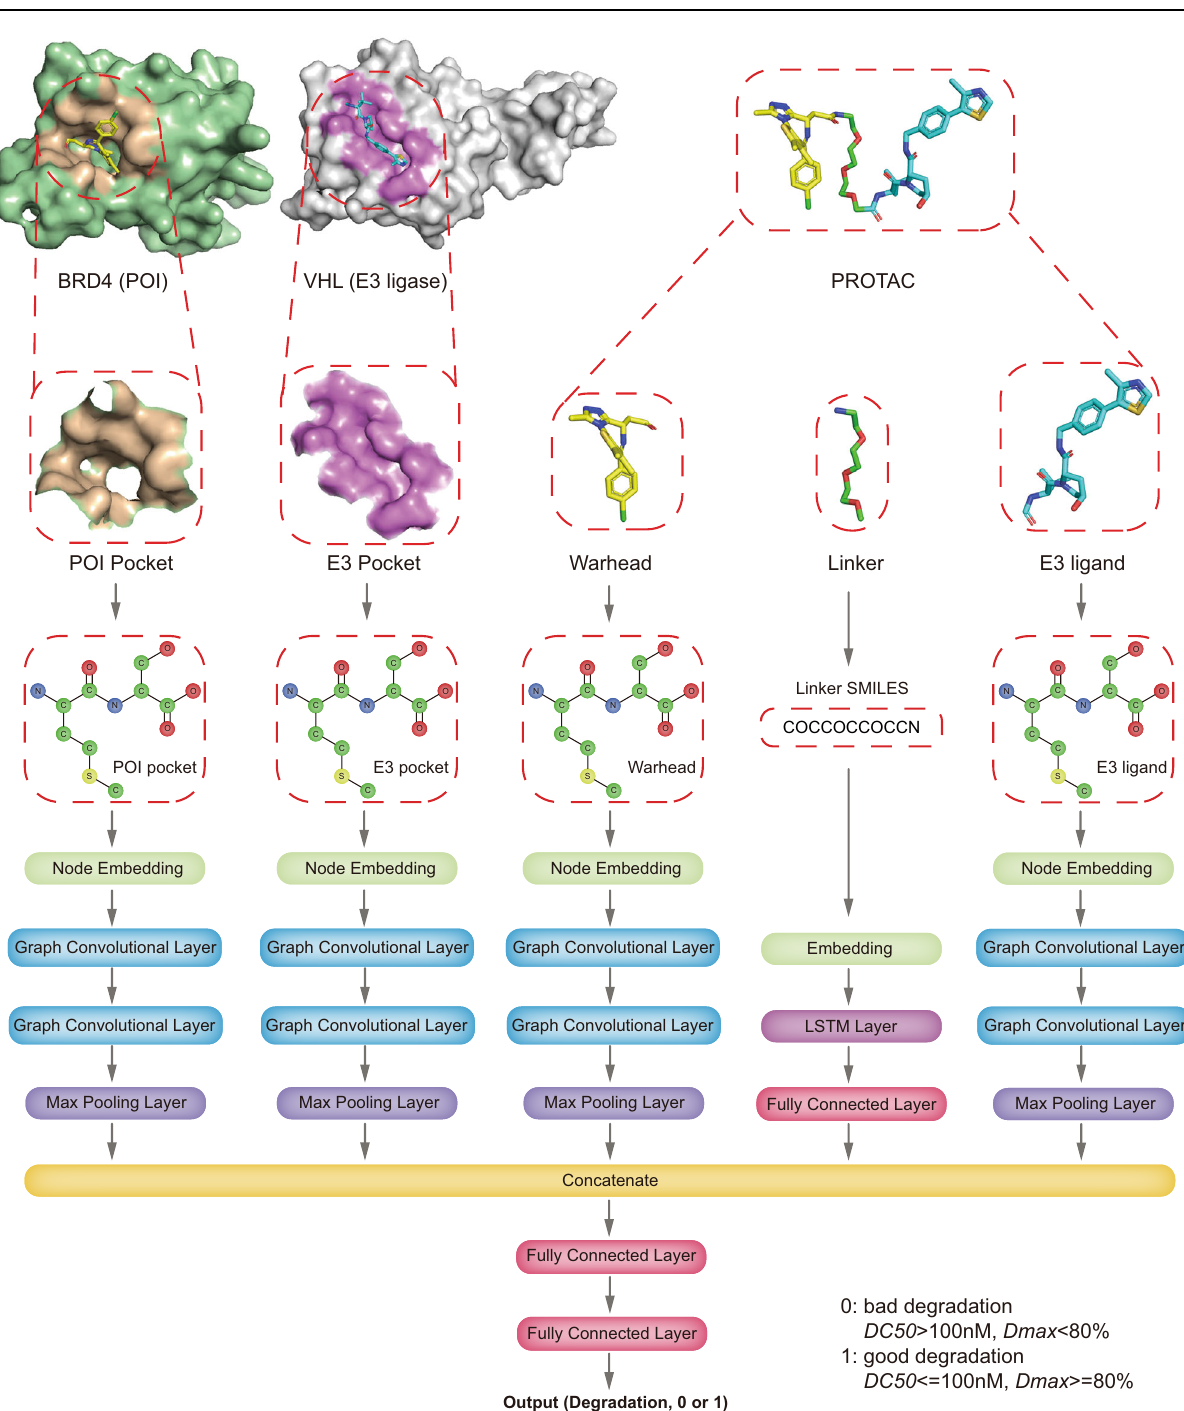
Fig.2|ThenetworkarchitectureofDeepPROTACs. ThepreprocessofPOI,E3ligaseandPROTACmolecule:extractionofbindingpocketfromPOI(BRD4)andE3ligase (VHL) and conversion to graph representations, conversion of PROTAC molecule to graph representations and